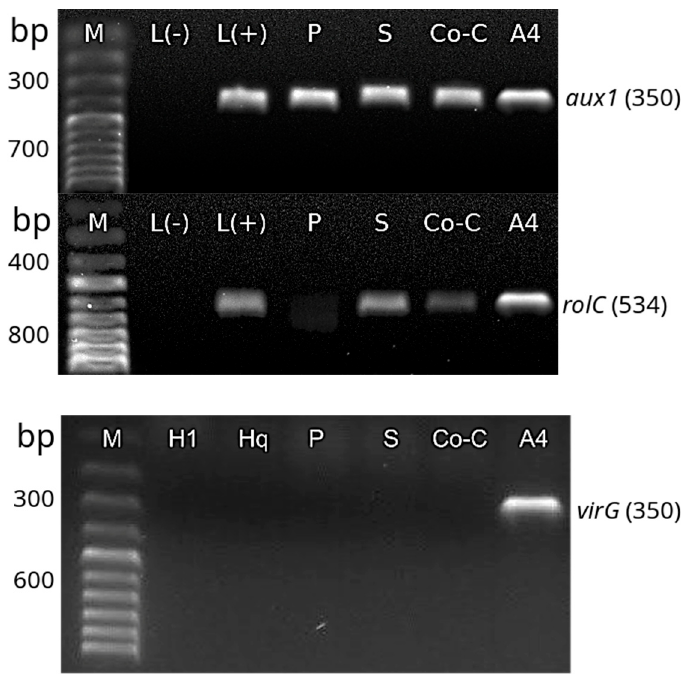
Figure 6. Polymerase chain reaction ( PCR) analysis of aux1 (350 bp), rolC (534 bp) and virG (350 bp) from T ‐ DNA of the Ri of A. rhizogenes . Molecular marker (M); Linum album L( − ) * (negative control); Linum album L(+)* (positive control); roots obtained by prick (P), sonication (S) and co ‐ culture (Co ‐ C); strain A4 of A. rhizogenes (A4); H. quinquenervis leaves (Hl) (negative control); wild roots of H. quinquenervis (negative control) (Hq). * Once nontransformed H. quinquenervis material was obtained, it was preferred as control.